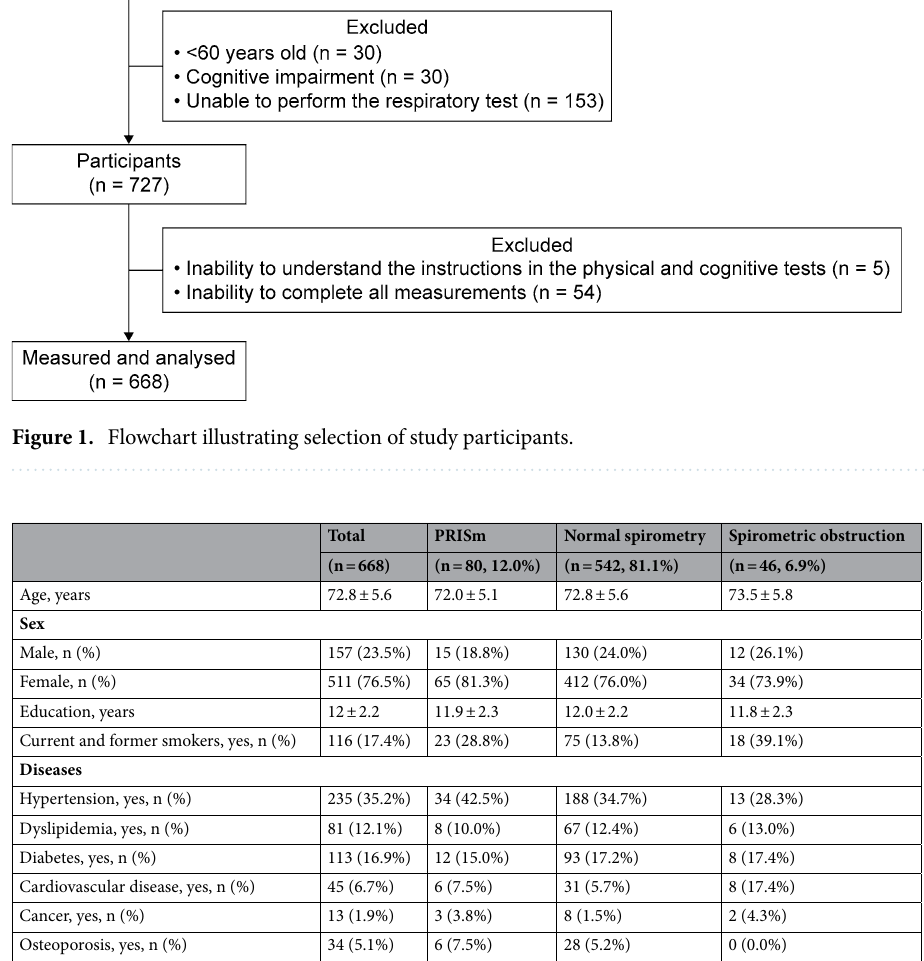
Table 1. Sociodemographic and clinical characteristics of the PRISm, spirometric obstruction, and normal spirometry groups. PRISm Preserved ratio impaired spirometry.